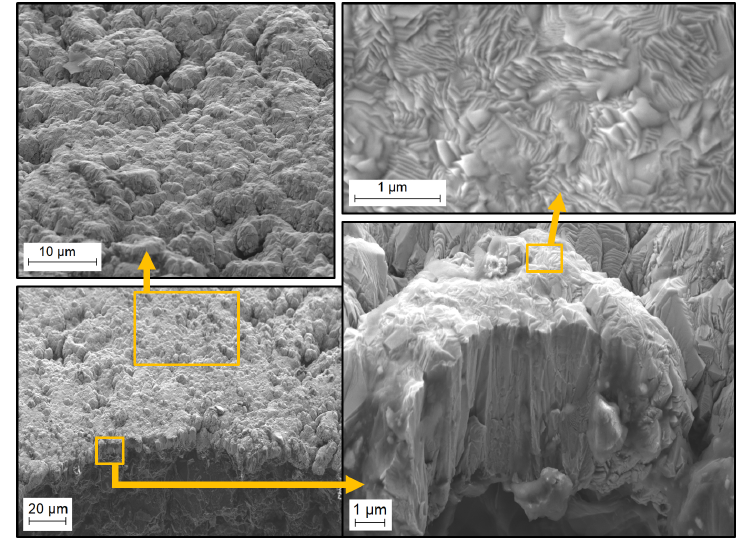
Figure 27. SEM observations of a Mo-coated graphite sample produced with HIPIMS. The fracture surface (B) and the coating surface ( top ) are